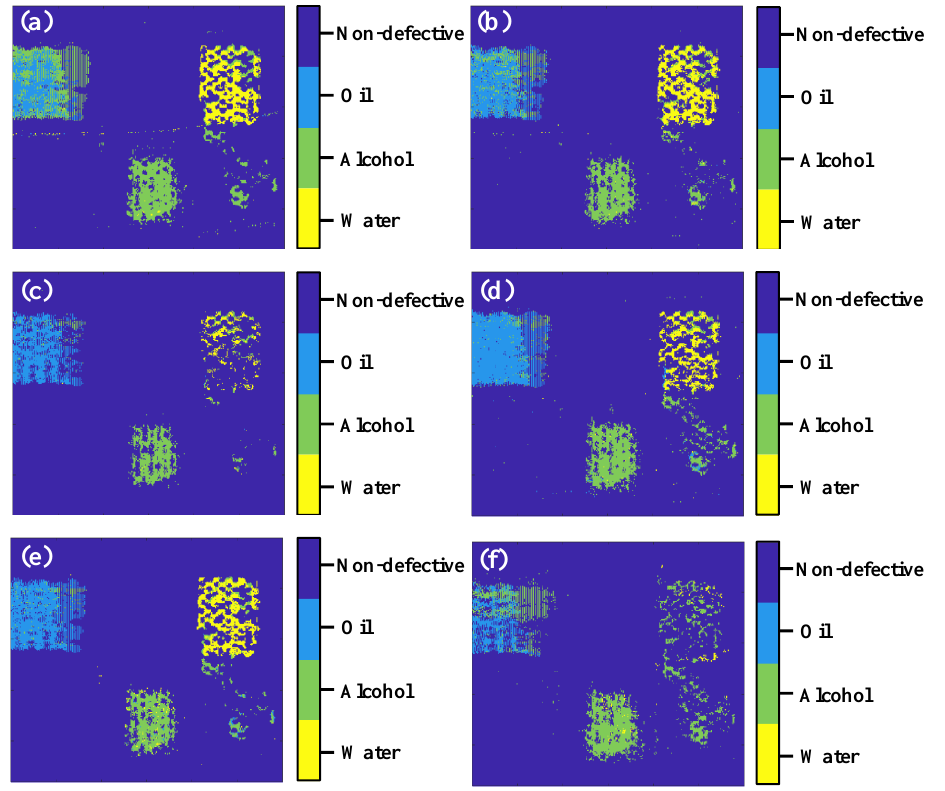
Figure 9. The classification results of three one-dimensional sequence models: ( a , b ) 1D-CSNN, ( c , d ) 1D-CNN, and ( e , f ) LSTM. ( a , c , e ) are obtained based on time-domain signals, and ( b , d , f ) are based on frequency-domain